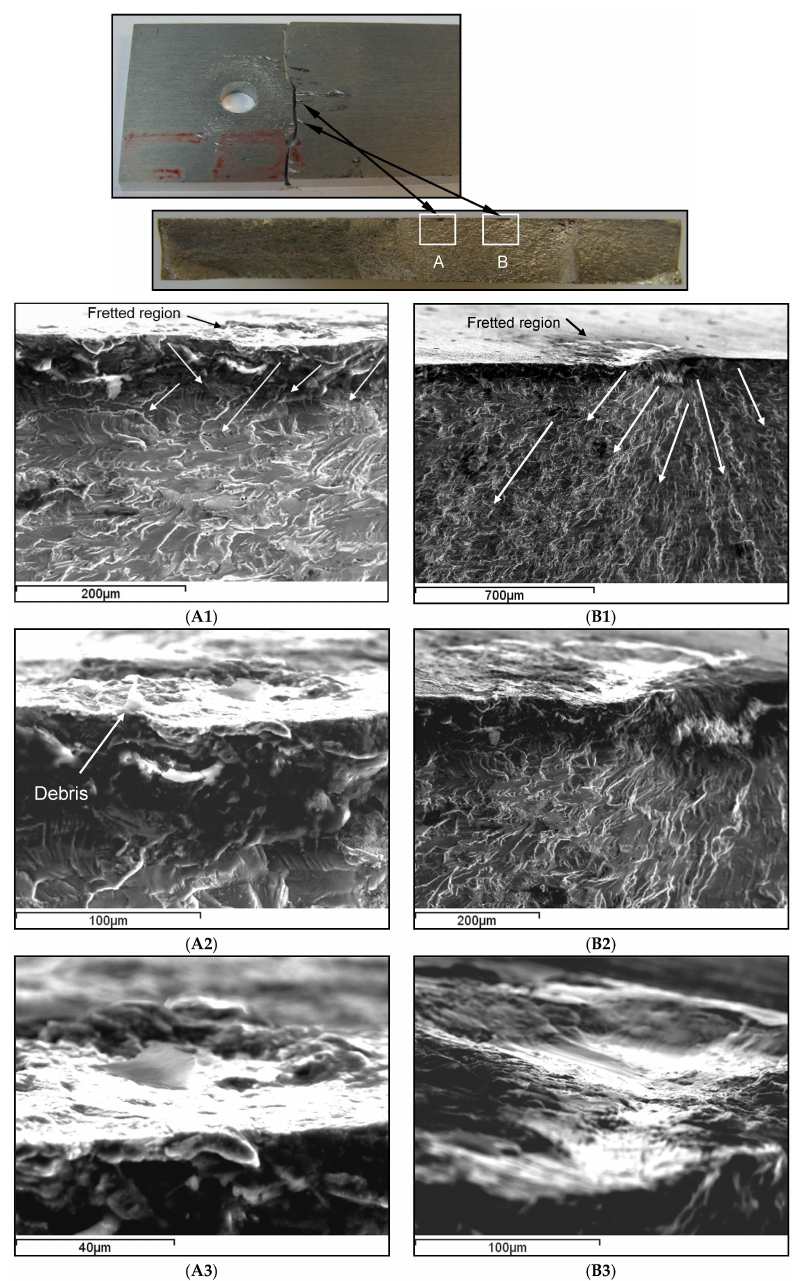
Figure 7. Fretting fatigue damage zones and crack nucleation sites; uncoated Al 7075-T6 plate clamped with T = 8 Nm that failed under S max = 80 MPa. ( A and B ) fretted regions; ( A1 – A3 and B1 – B3 ) fretted regions at higher